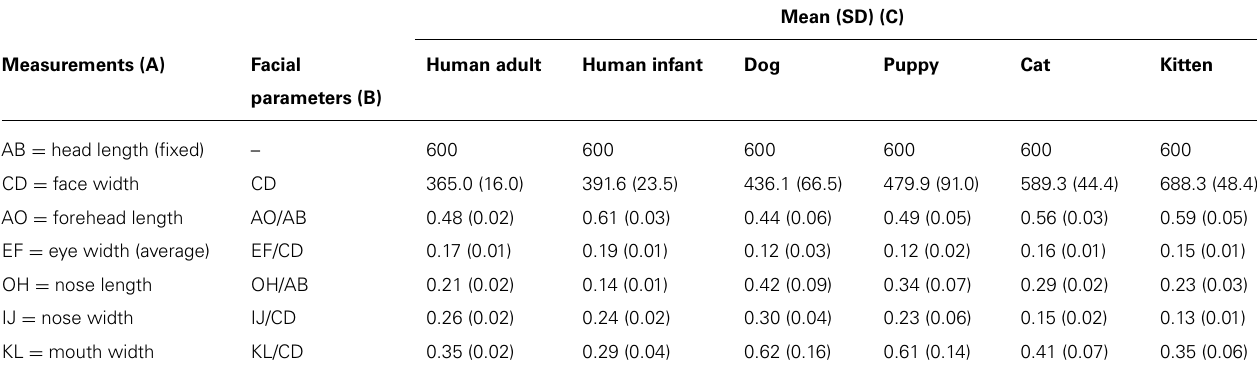
Table 1 | Measurements taken (A) and baby schema facial parameters (B) in a sample of 20 unmanipulated images (mean and SD; C).